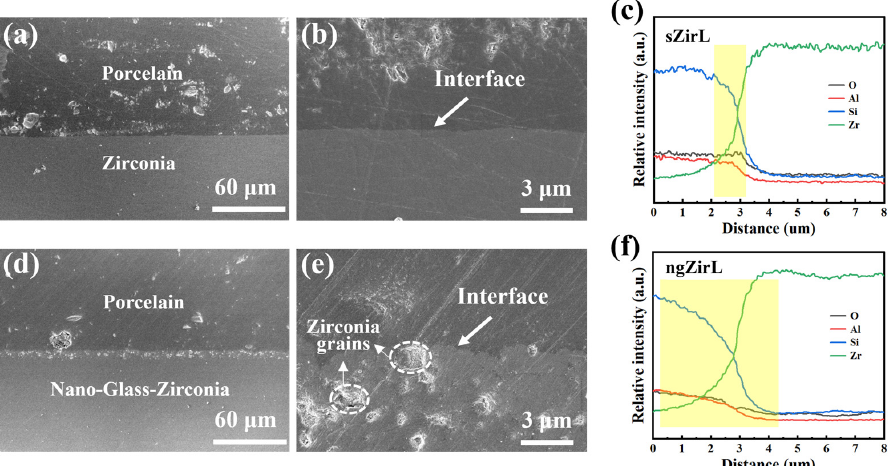
Figure 7. The SEM images and EDS line scan results at the interface. The SEM images of sZirL at the interface ( a , b ), the EDS line scan results of O, Al, Si and Zr at the interface ( c ). The SEM images of ngZirL at the interface ( d , e ), the EDS line scan results of O, Al, Si, and Zr at the interface ( f ). Figure 8 shows the BSE images at the interface of sZirL and ngZirL. In the sZirL region of interface, while in the ngZirL group, grain contours and darker areas (white circles) among grains could be observed, which indicated the presence of different com- positions. The elemental mapping analysis of the corresponding areas displayed a homo- geneous distribution of Si and Zr at the zirconia substrate in the sZirL group. In the ngZirL group, the enhancement of the Si signal and the attenuation of the Zr signal can be de- tected at the dark area (Figure 8e,f).